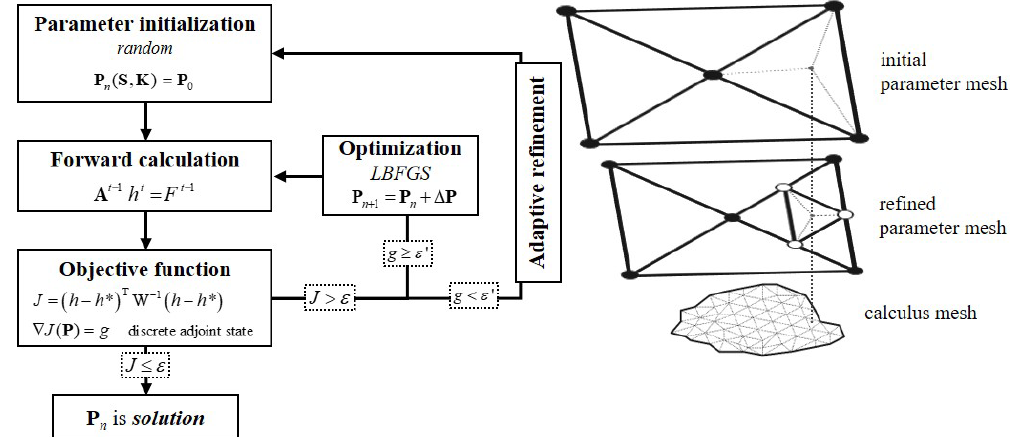
Figure 4. Inversion algorithm (adapted from Rambourg et al., 2020) – on the left, the general algorithm, and on the right, the adaptive parametrization and its first refinement